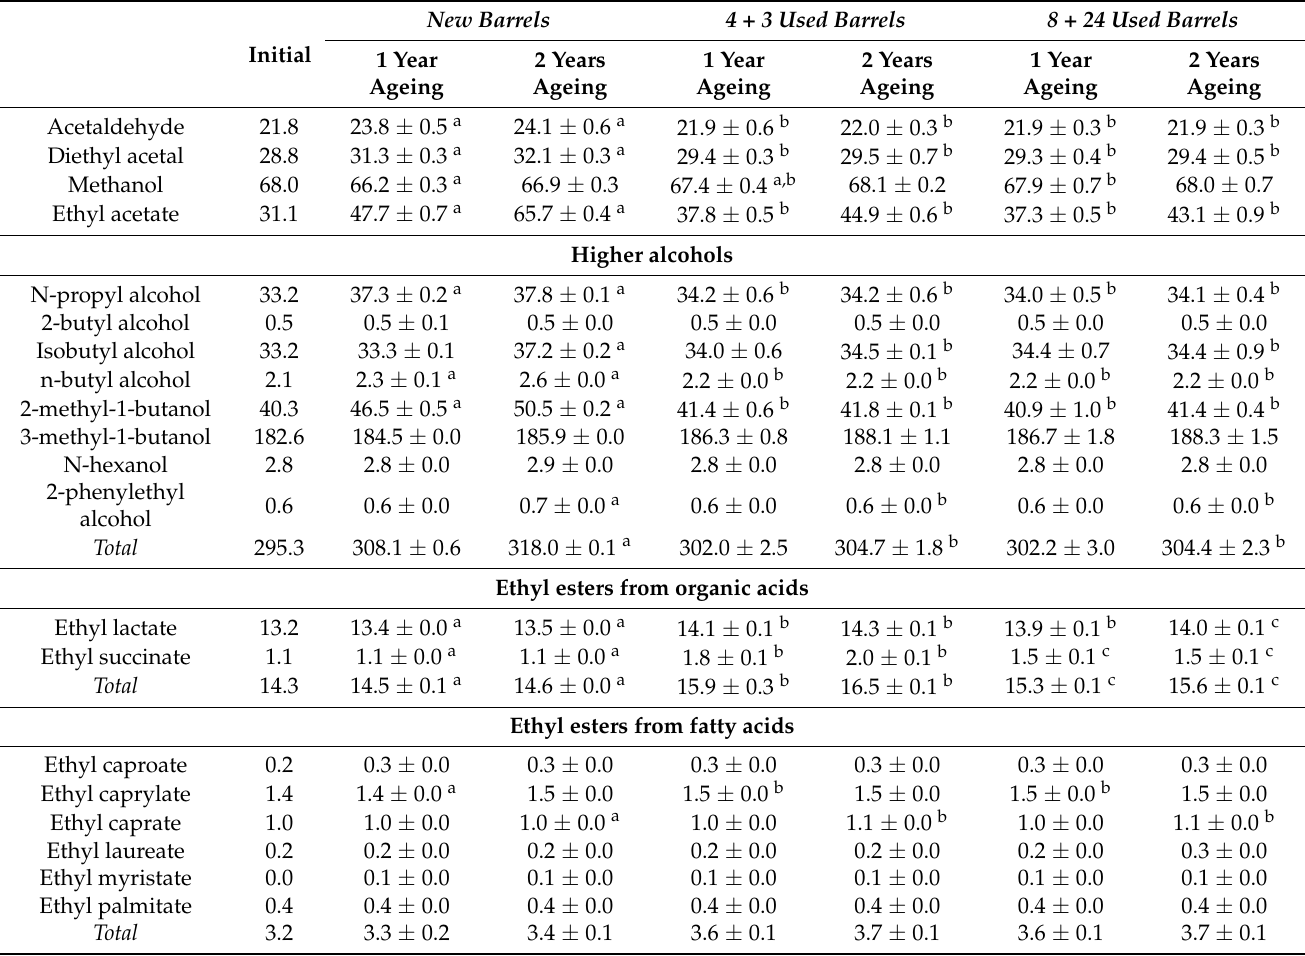
Table 7. Aldehydes, acetal, methanol, esters and higher alcohols contents (mg/100 mL of 100% vol. alcohol) in the brandies